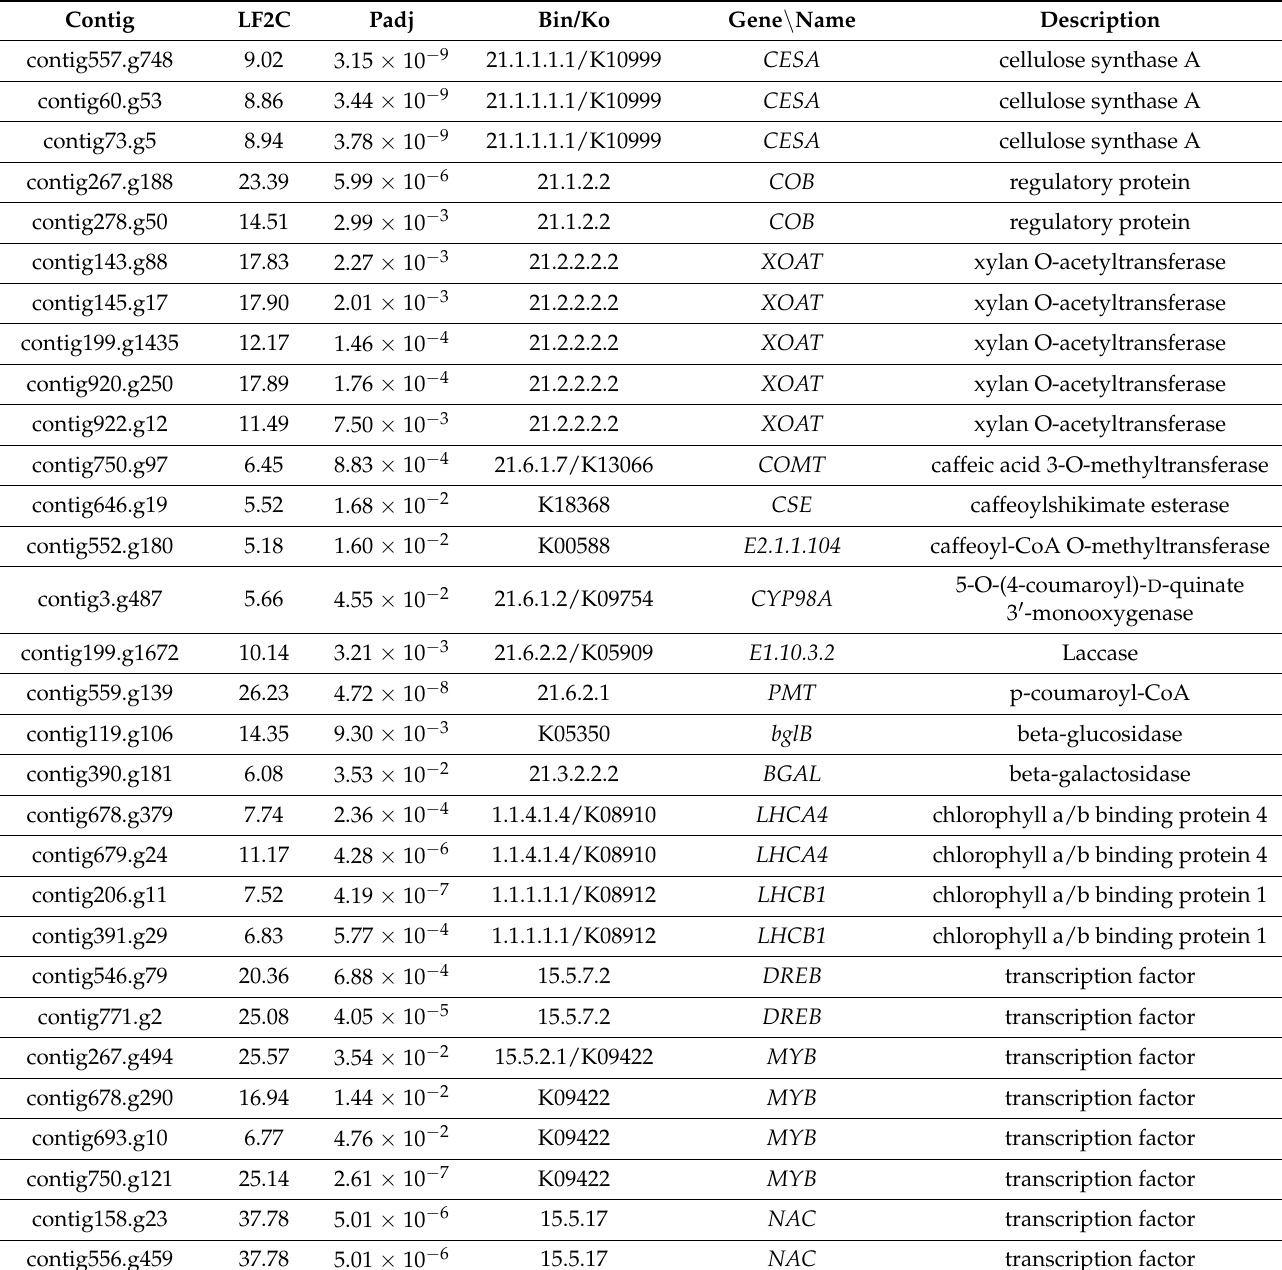
Table 2. Candidate genes associated with PHH in D. dumetorum tuber in Fonkouankem 1 3DAH vs. AH. Contig LF2C Padj